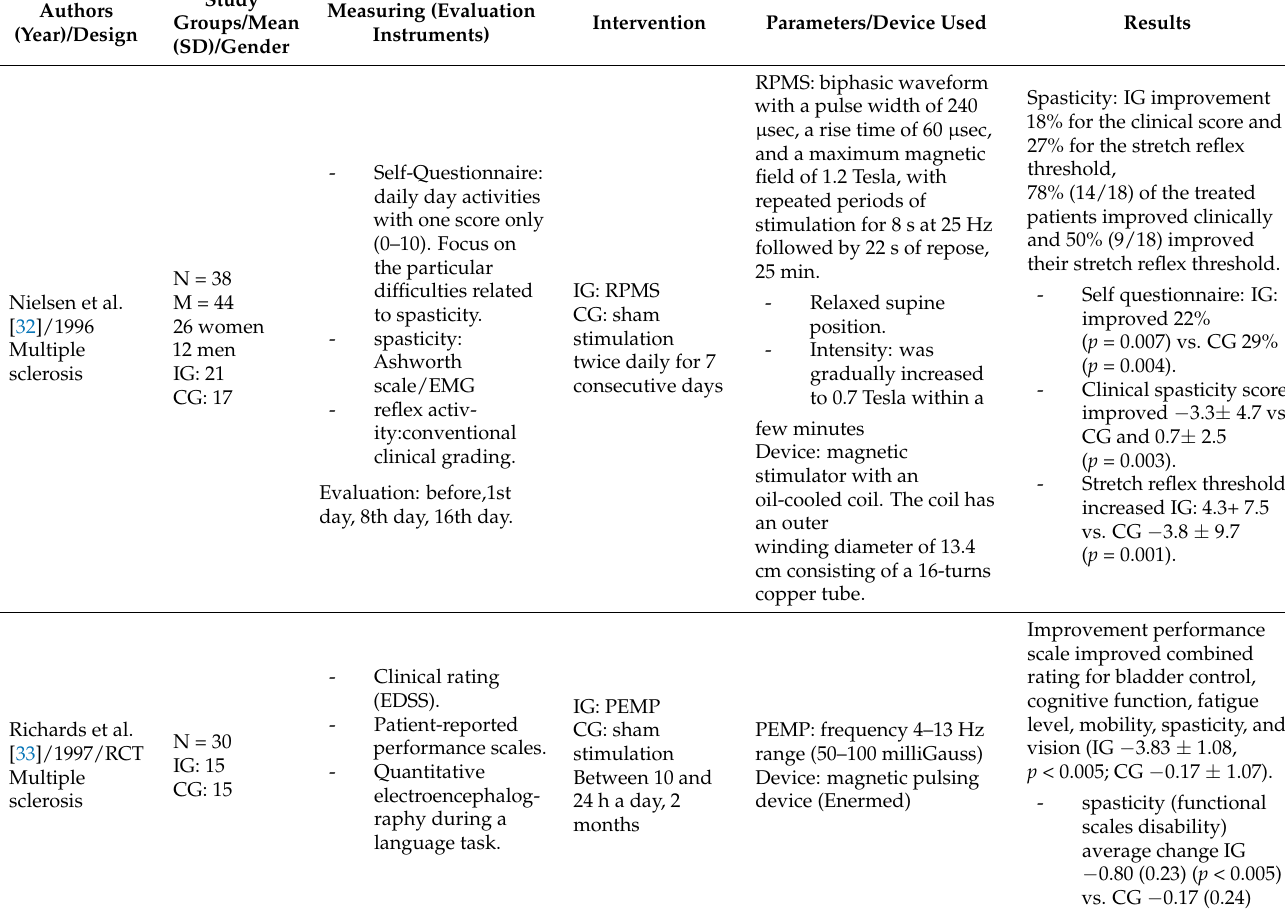
Table 2. Principal studies